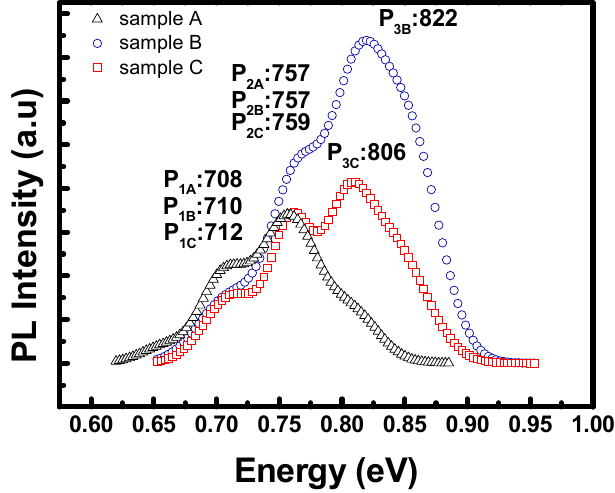
Figure 2. Low-temperature photoluminescence spectra of InN samples grown at different tempera- tures, with the peak positions labeled.